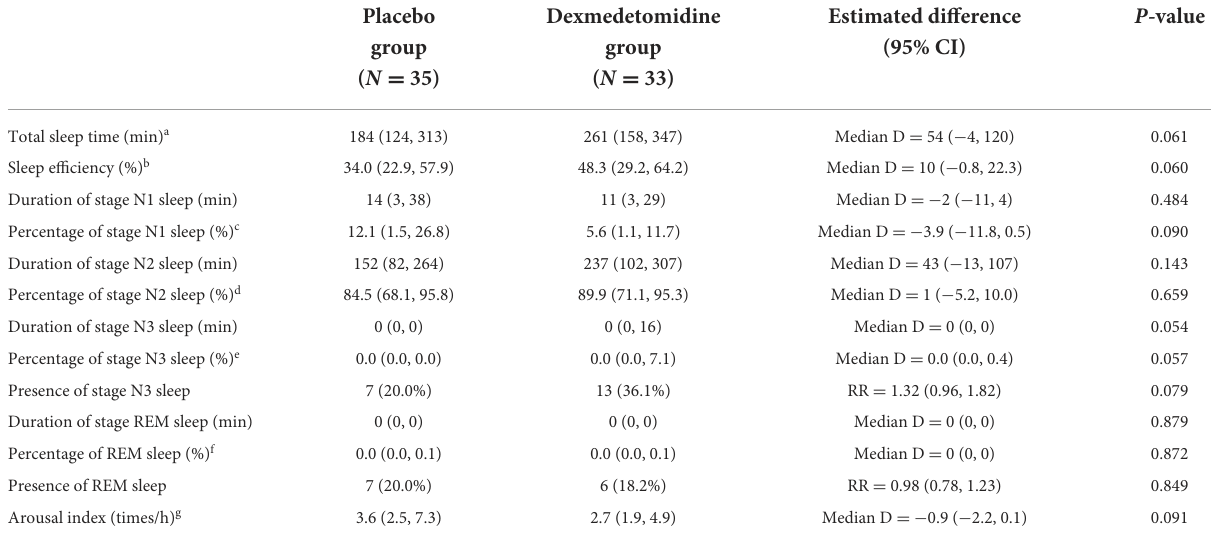
TABLE 4 Sleep architecture analyses.